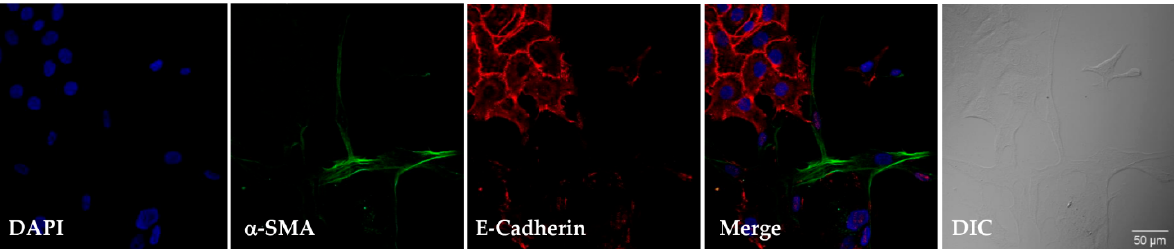
Figure 3. Low α -SMA levels and high E-cadherin levels were detected during the epithelial–mesenchymal transition (EMT)-like process of fibroblasts by confocal immunofluorescence microscopy. Fibroblasts and ELC were grown on coverslips, fixed with paraformaldehyde, and stained with α -SMA and E-cadherin antibodies, followed by incubation with fluorescent dye-tagged secondary antibodies. Images show a sample containing approximately 20% fibroblasts and 80% ELC. DAPI was used to stain nuclei. α -SMA (green), E-cadherin (red), and nuclei (blue). Stained cells were visualized by confocal fluorescence microscopy (original magnification ×40). Differential interference contrast (DIC) is also shown.